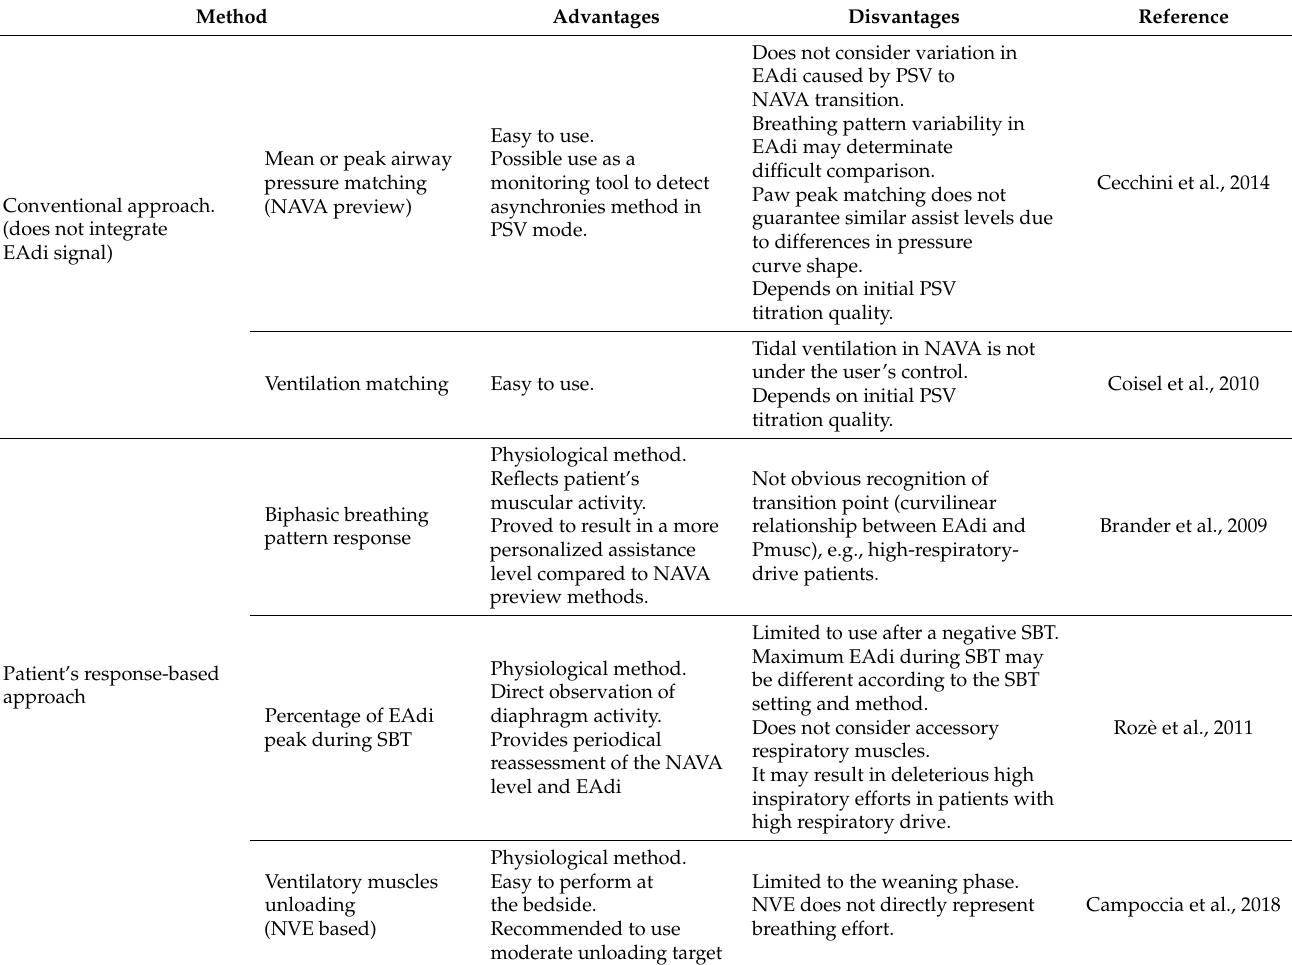
Table 1. NAVA level setting